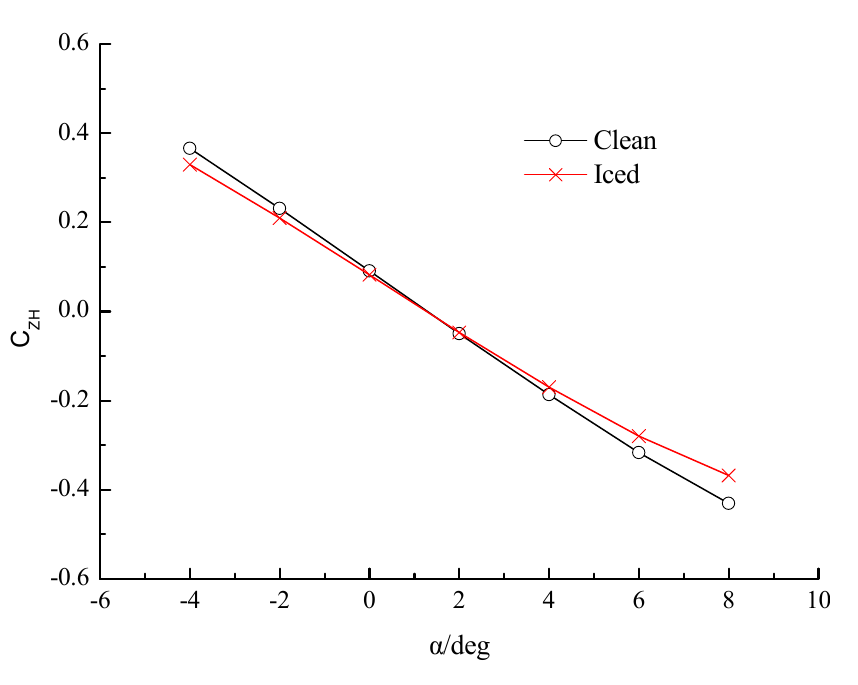
Figure 10. The curves of C ZH with angle of attack. C with angle of attack. Figure 10. the curves of ZH